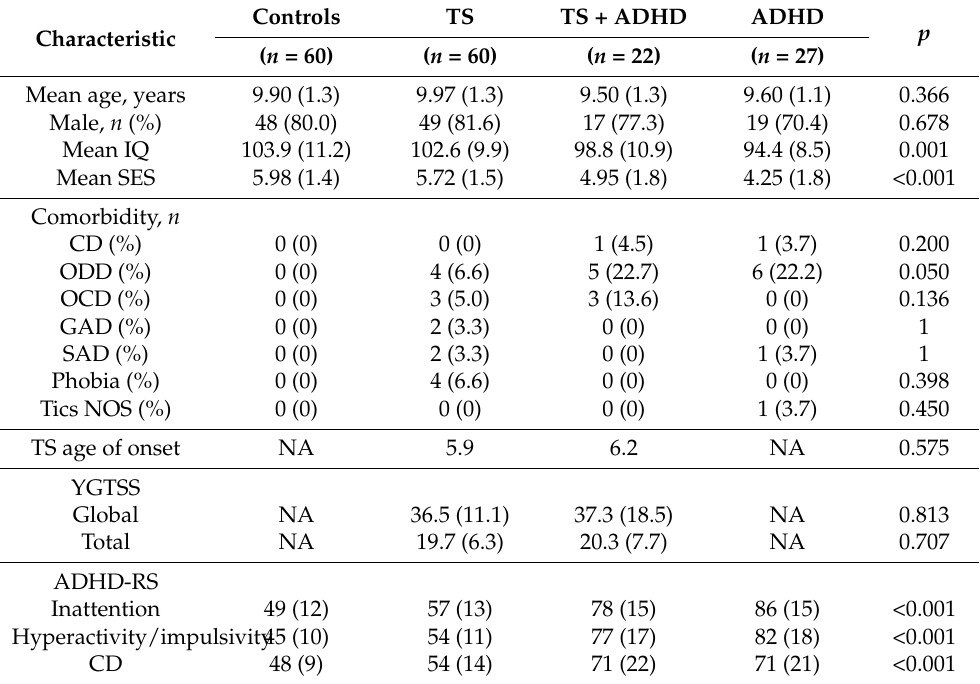
Table 1. Participant characteristics for the total